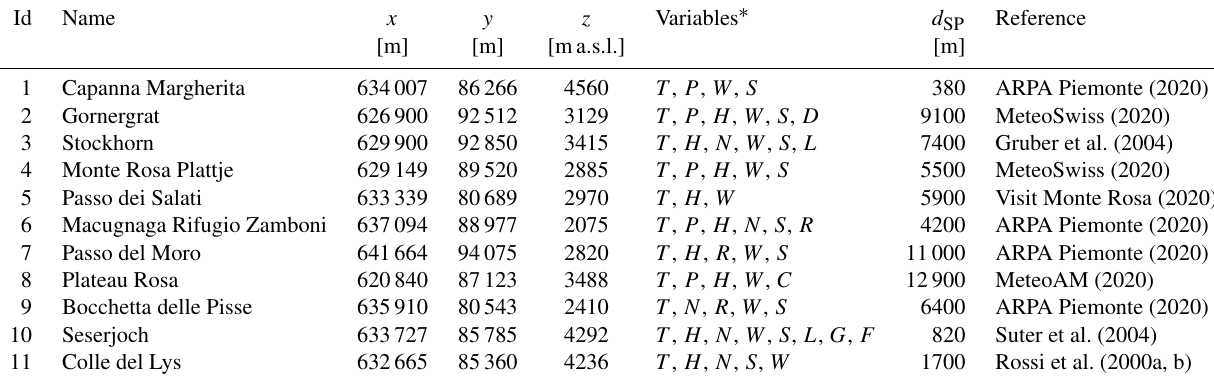
Table 2. AWS series included in this study. Numbering corresponds to Fig. 1b. x , y , and z are metric CH1903/LV03 coordinates. d SP is the horizontal distance to the CG saddle point (labeled SP in Fig. 1a). Stations 10 and 11 were deployed temporarily for energy-balance studies; permanent stations 3, 4, and 6 were installed between 2006 and 2010, while the others were already operational before the CM AWS. Further AWS information is reported in Mattea